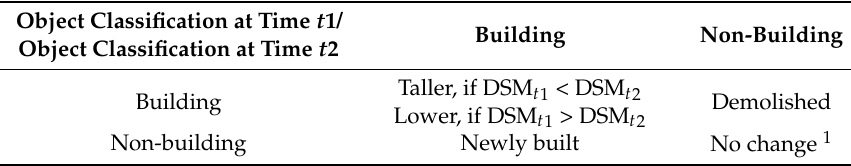
Table 1. Change type determination with the guidance of a priori